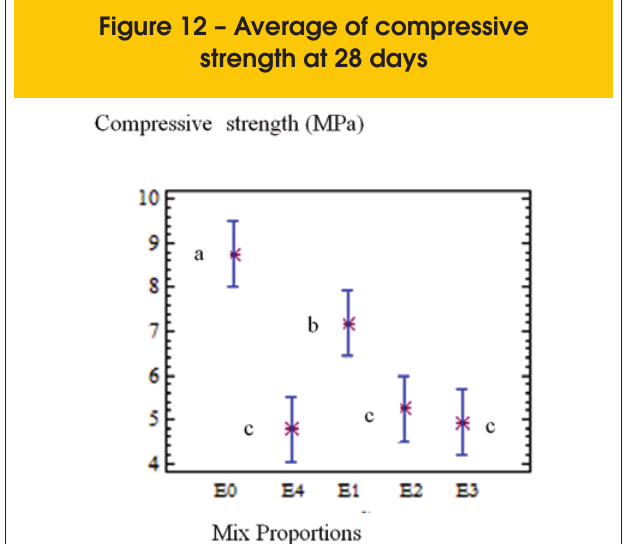
Figure 12 – Average of